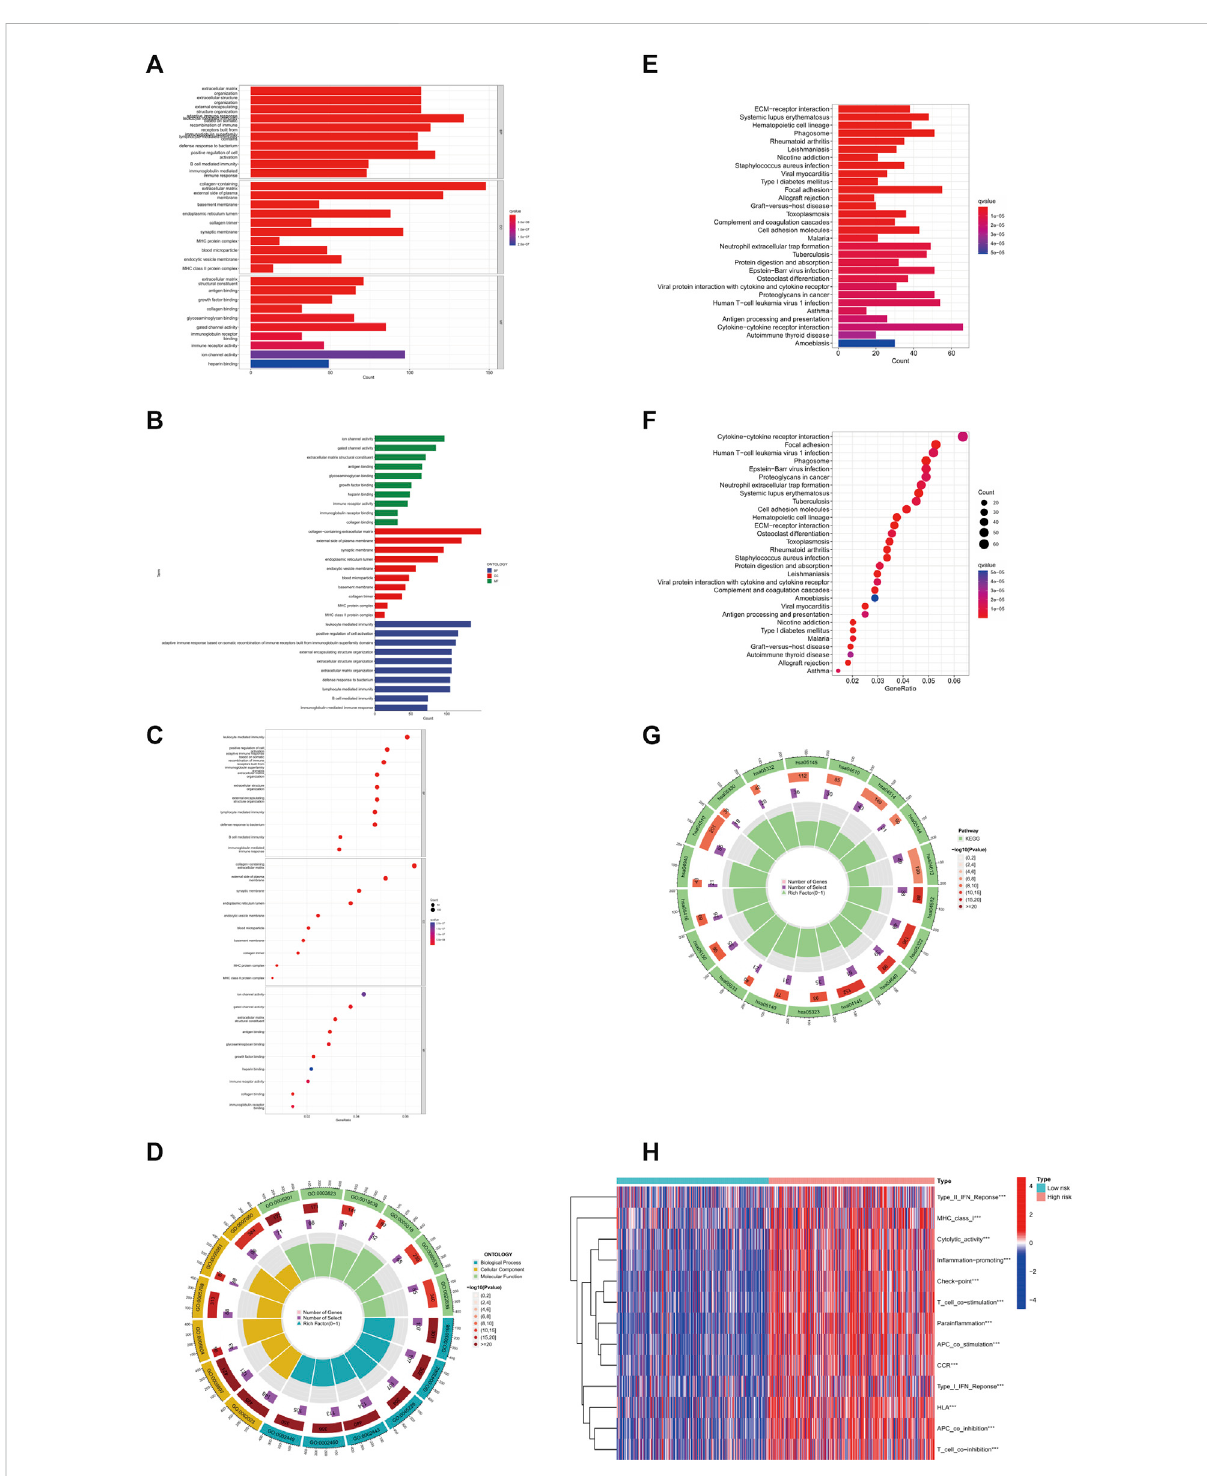
FIGURE 4 GLS involved in copper death of glioma cells. (A – D) GO enrichment analysis. (E – G) KEGG enrichment analysis. (H) Immune-related analysis. *** p < 0.001, ** p < 0.01, * p < 0.05. Abbreviation: GO, Gene Ontology. KEGG, Kyoto Encyclopedia of Genes and Genomes.